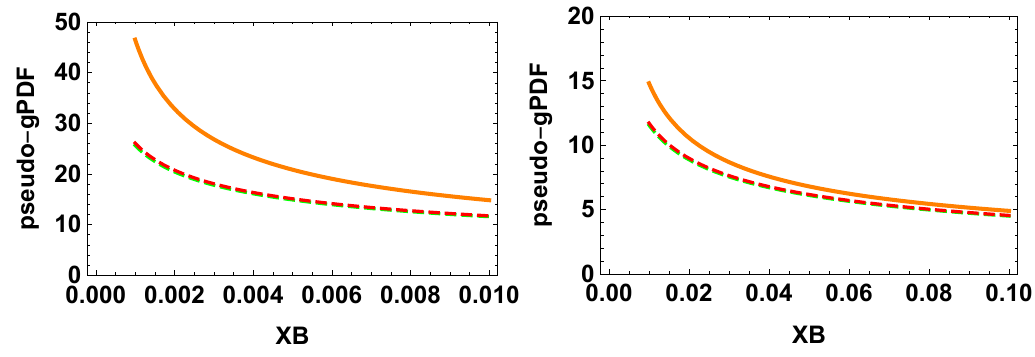
Figure 9 . In the left panel we plot pseudo-PDF with BFKL resummation, eq. (7.2) (orange curve), and the LT (green dashed curve) and LT+NLT (red dashed curve) of pseudo-PDF result (7.5); the value of x B is between 0.001 to 0.02. In the right panel we plot the same curves in a different range of x B between 0.01 to